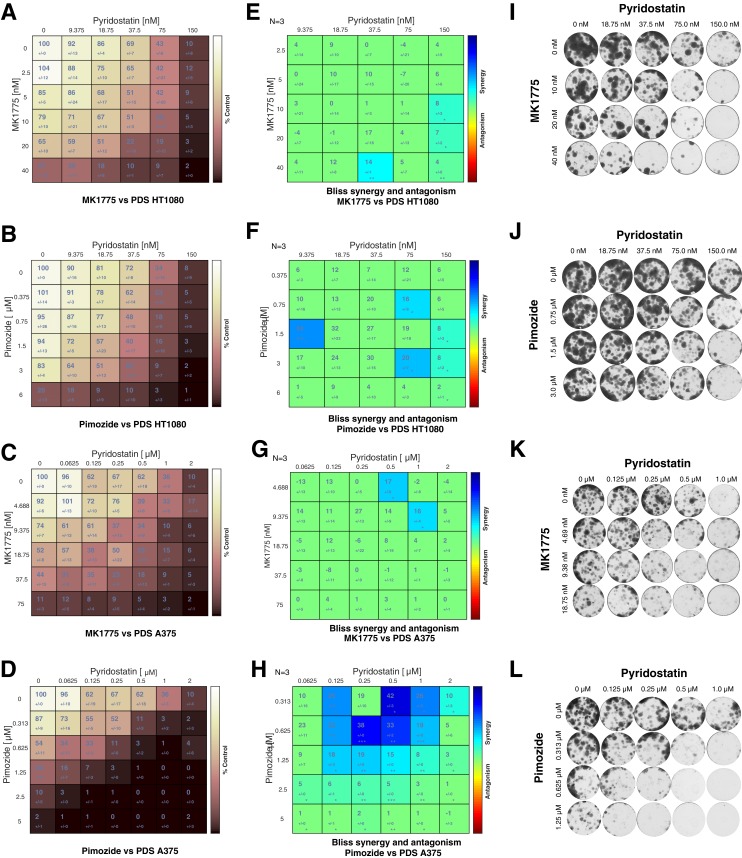
Clonogenic cell survival assay demonstrates enhanced cell death upon treatment with PDS in combination MK1775 or pimozide.Clonogenic survival of HT1080 and A375 cells after 8-day exposure to the indicated drug combinations. (A–D) Colony intensity values, determined by ColonyArea Image J plugin, were expressed as a percentage of untreated (DMSO only) controls. (E–H) BLISS synergy matrix derived using Combenefit software package from normalised colony intensity values. Mean ± standard deviation shown (I–L) Representative SRB-stained colonies for A375 (K and L) and HT1080 (I and J) cells. Three biological replicates were performed.